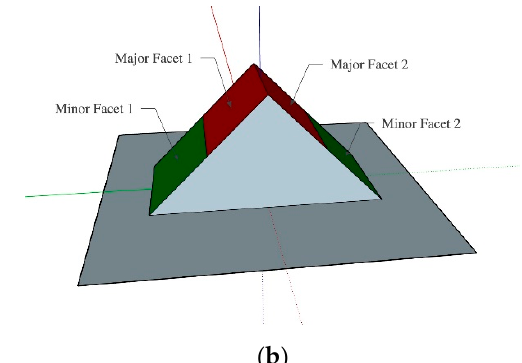
Figure 10. Example of the peak type. These facets are the same facets shown in Figure 6c ( σ max = 1000 MPa, R = 0.1, N f = 3.0 × 10 5 ). ( a ) 3D-SEM image; ( b ) 3D-model schematic image.